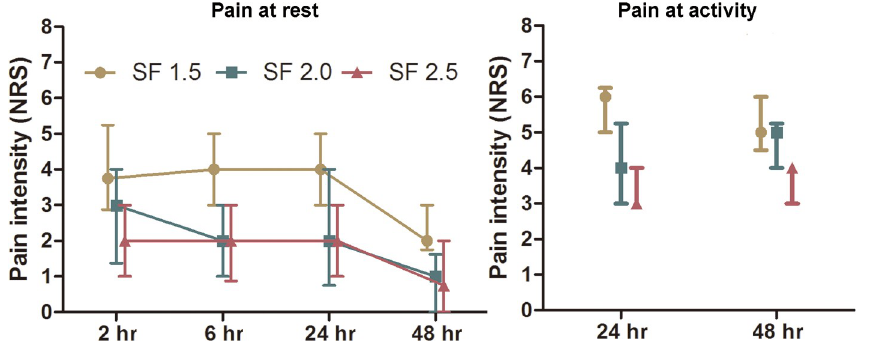
Fig 3. The pain intensity over the first 48 h based on NRS. On the left is the pain intensity at rest over observational time. On the right is the pain intensity when coughing at 24 h and 48 h. The data was presented with median and interquartile range.